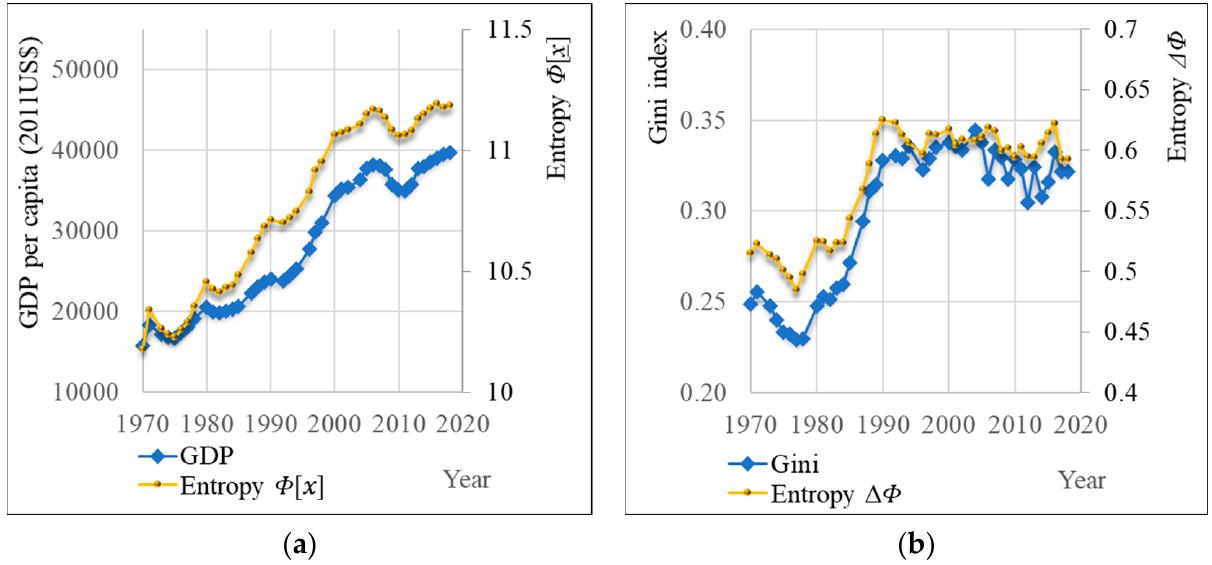
Figure 15. United Kingdom (1970–2018): ( a ) GDP per capita and Φ [ x ]; (b) Gini and entropic index of inequality Δ Φ .